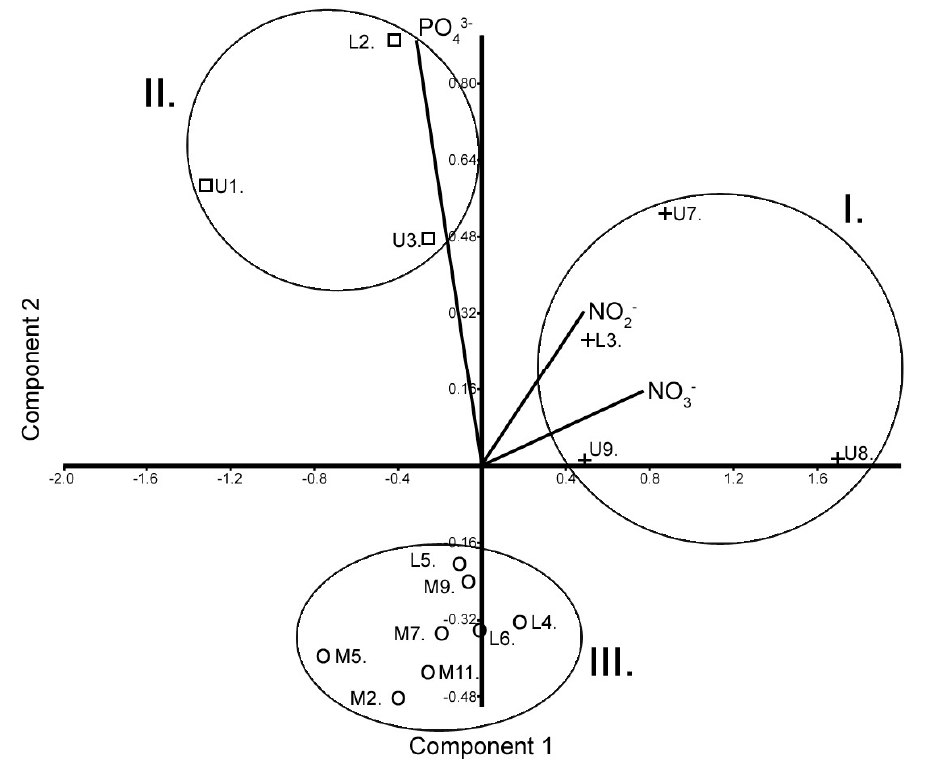
Figure 2. Results for the spring period of the principal component analysis applied to the physical and chemical variables at the sampling points of the sampling area. Group I: cross (+). Group II: empty square ( □ ). Group III: empty circle (o). Upper Area: U1 − U9; Middle Area: M1 − M11; Lower Area: L1 − L6.